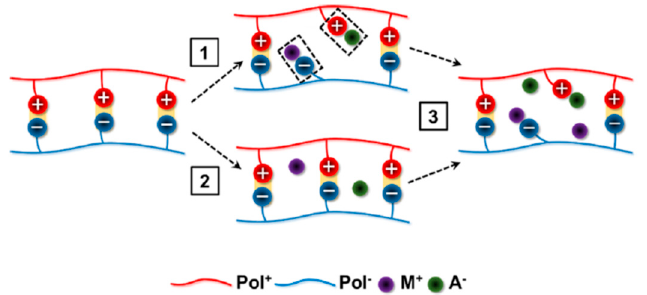
Figure 8. An ion-free coacervate is shown on the left. Salt ions M+ and A − dope the coacervate, either by breaking the Pol + Pol − pairs and acting as counterions (path 1) or by not formally breaking the Pol + Pol − pairs but remaining as co-ions (path 2). Paths 1 and 2 can occur sequentially or simul- taneously to give a mix of counter- and co-ions (shown on the right). Reproduced with permission from Macromolecules, 2020, 53, 5465. Copyright 2020 American Chemical